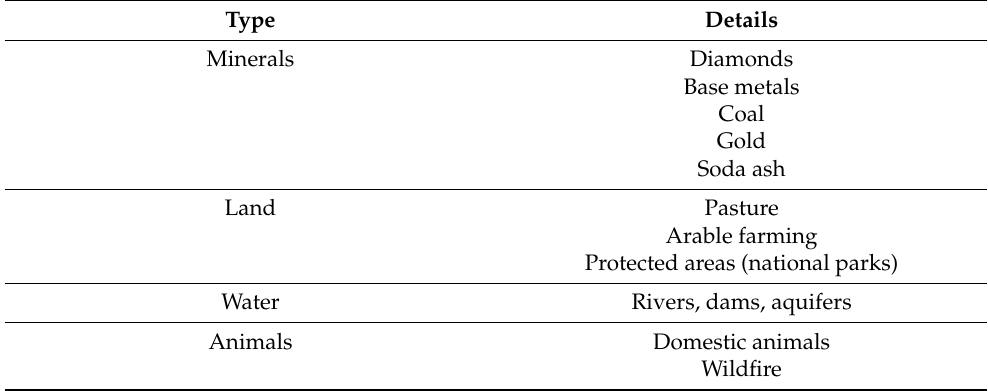
Table 1. Components of natural capital in Botswana